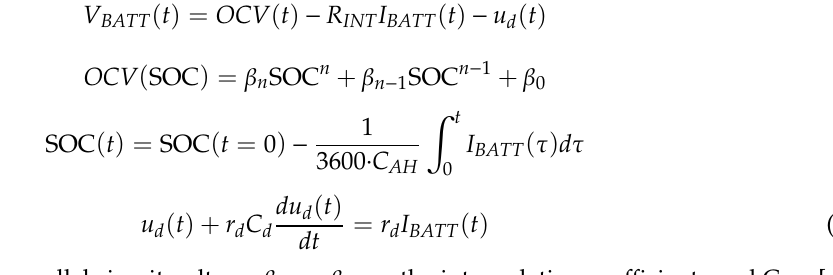
Figure 3. On-board Hybrid ESS electric model. Figure 4. Equivalent circuit of the battery pack ( a ) and SC pack ( b ).